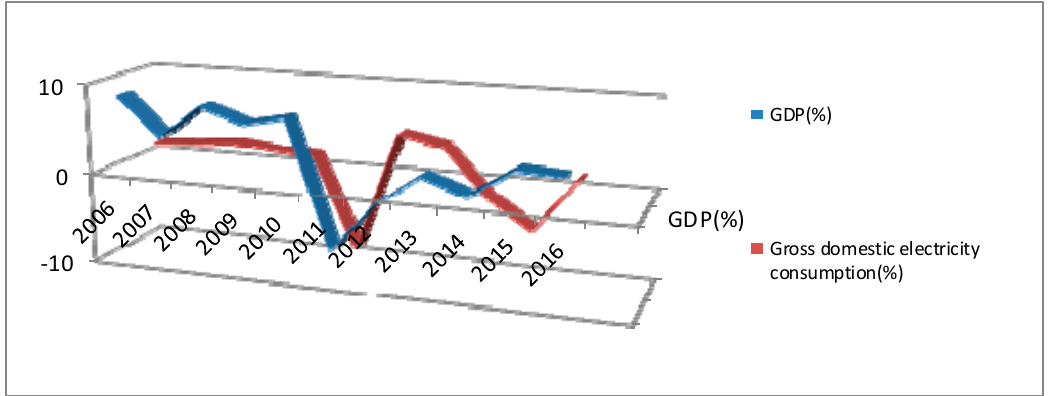
Figure 2. Correlation between GDP and gross national electricity consumption in Romania. Source: authors’ representation based on information extracted from the Romanian National Institute of Statistics [34].